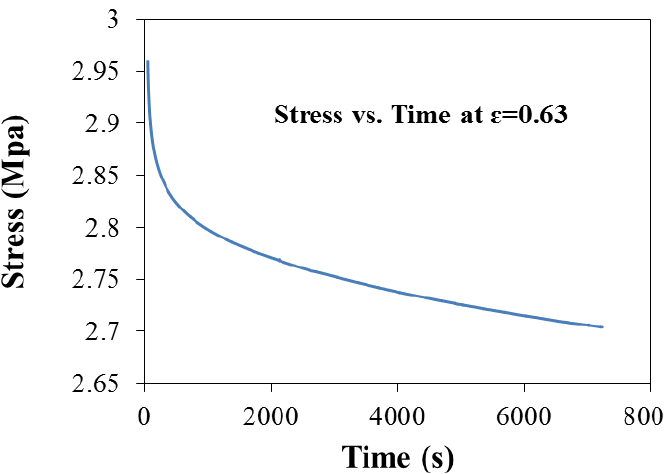
0.63 at room temperature. Initially 50 N were applied; the program was adjusted to maintain such strain level and stress over time recorded.